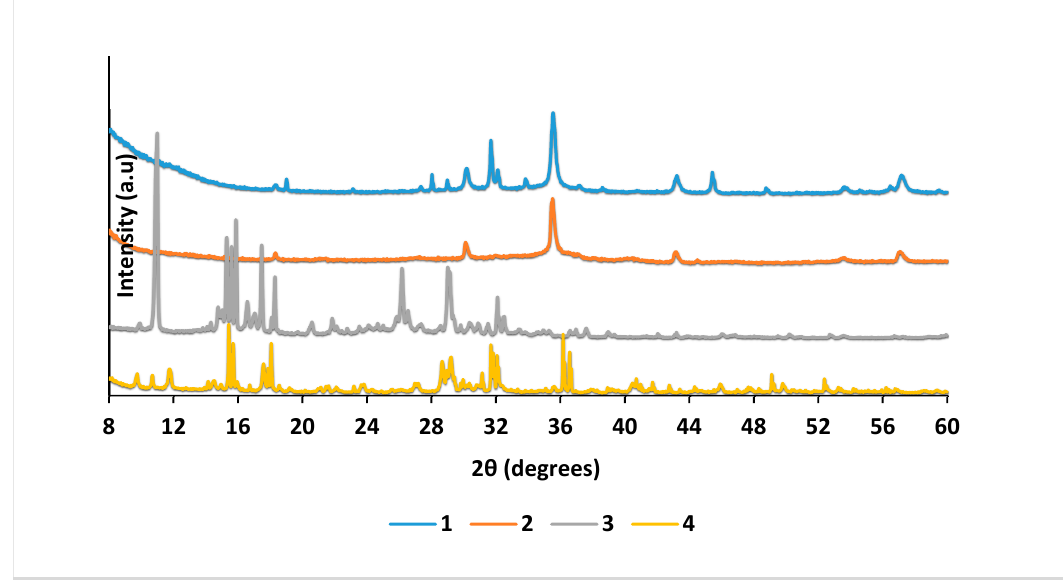
Figure 1. Powder X-ray diffraction (PXRD) patterns of 1 – 4 .